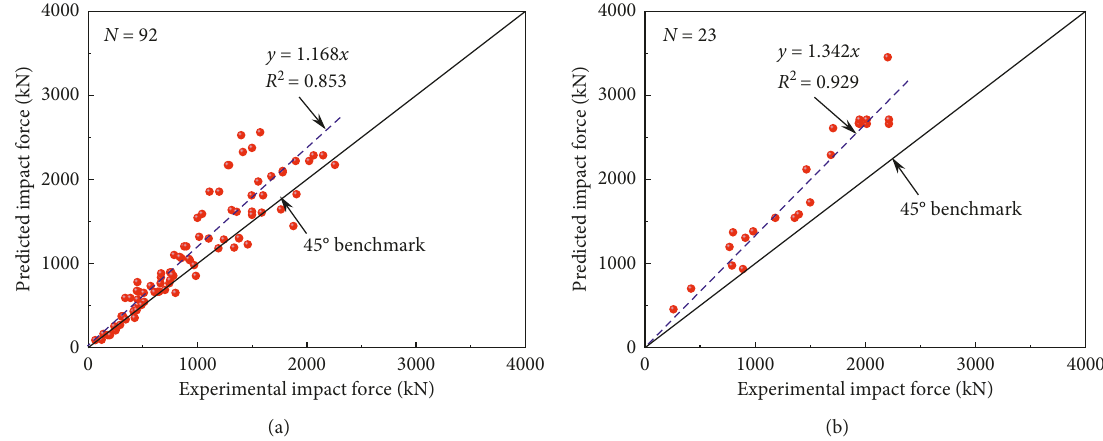
Figure 12: Comparison of experimental and predicted values of peak impact force. (a) Spherical nose. (b) Flat nose.